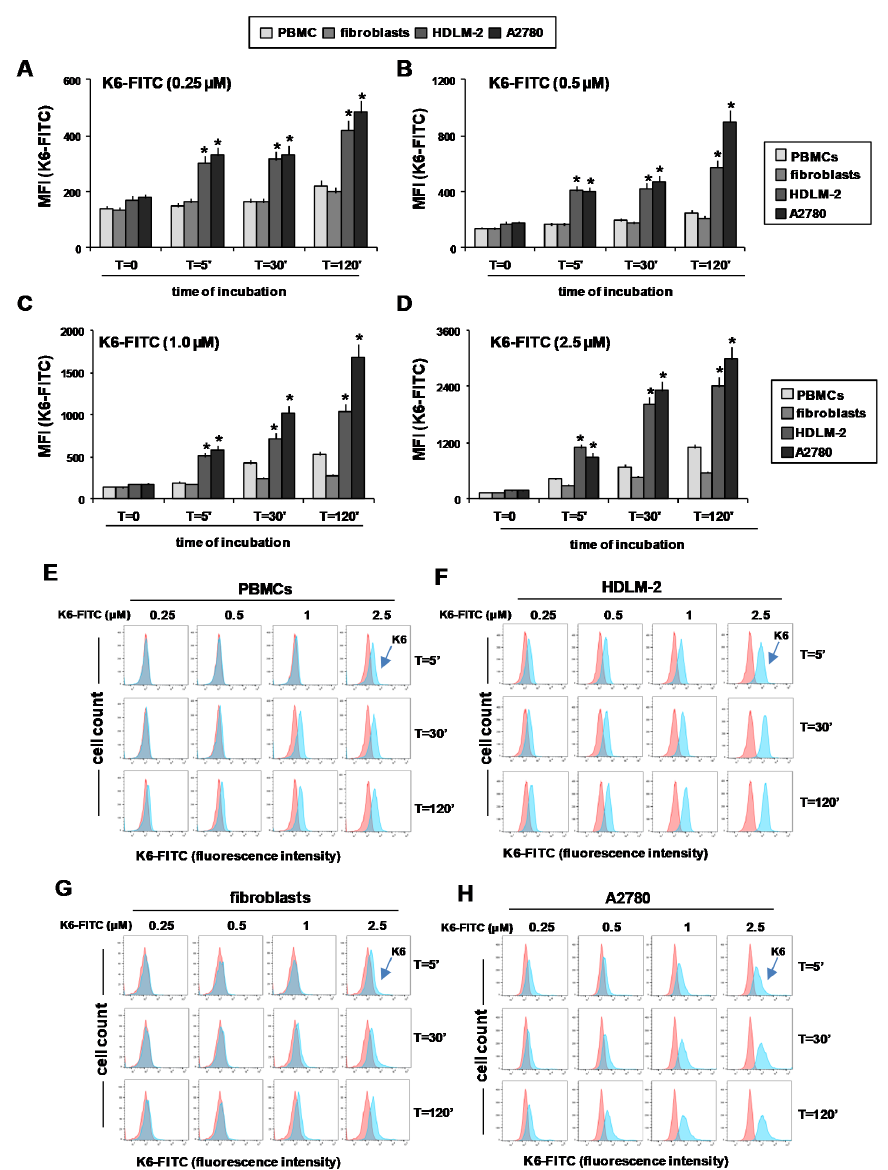
Figure 5. Comparison of K6-FITC uptake between normal healthy cells and tumor cells. ( A – D ) Mean fluorescence intensity (MFI) of normal healthy cells, peripheral blood mononuclear cells (PBMCs) and fibroblasts, tumor cells HDLM-2 and A2780 treated with ( A ) 0.25 µM, ( B ) 0.5 µM, ( C ) 1 µM, ( D ) 2.5 µM K6-FITC and analyzed by flow cytometry after 0, 5, 30 and 120 min of incubation. Bar charts are mean and SD of three independent experiments. * p < 0.05 vs. healthy cells (PBMNc and fibro- blasts). ( E – H ) Representative cytofluorimetric histograms of ( E ) PBMCs, ( F ) HDLM-2, ( G ) fibro- blasts, and ( H ) A2780 treated with different concentrations (0.25–2.5 µM) of K6-FITC for 5, 30, and 120 min.